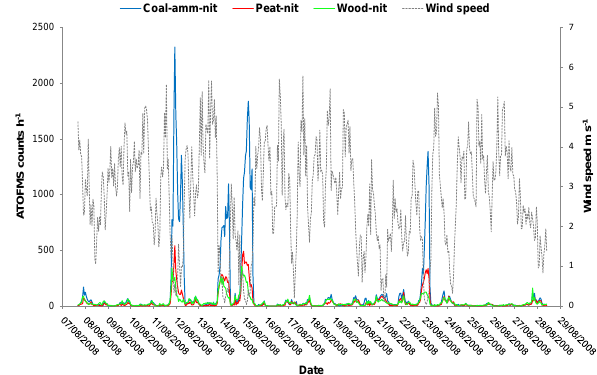
Fig. 7. Hourly integrated ATOFMS particle counts for the Coal- amm-nit, Peat-nit and Wood-nit subclasses and hourly averaged wind speed values for 7–28 August